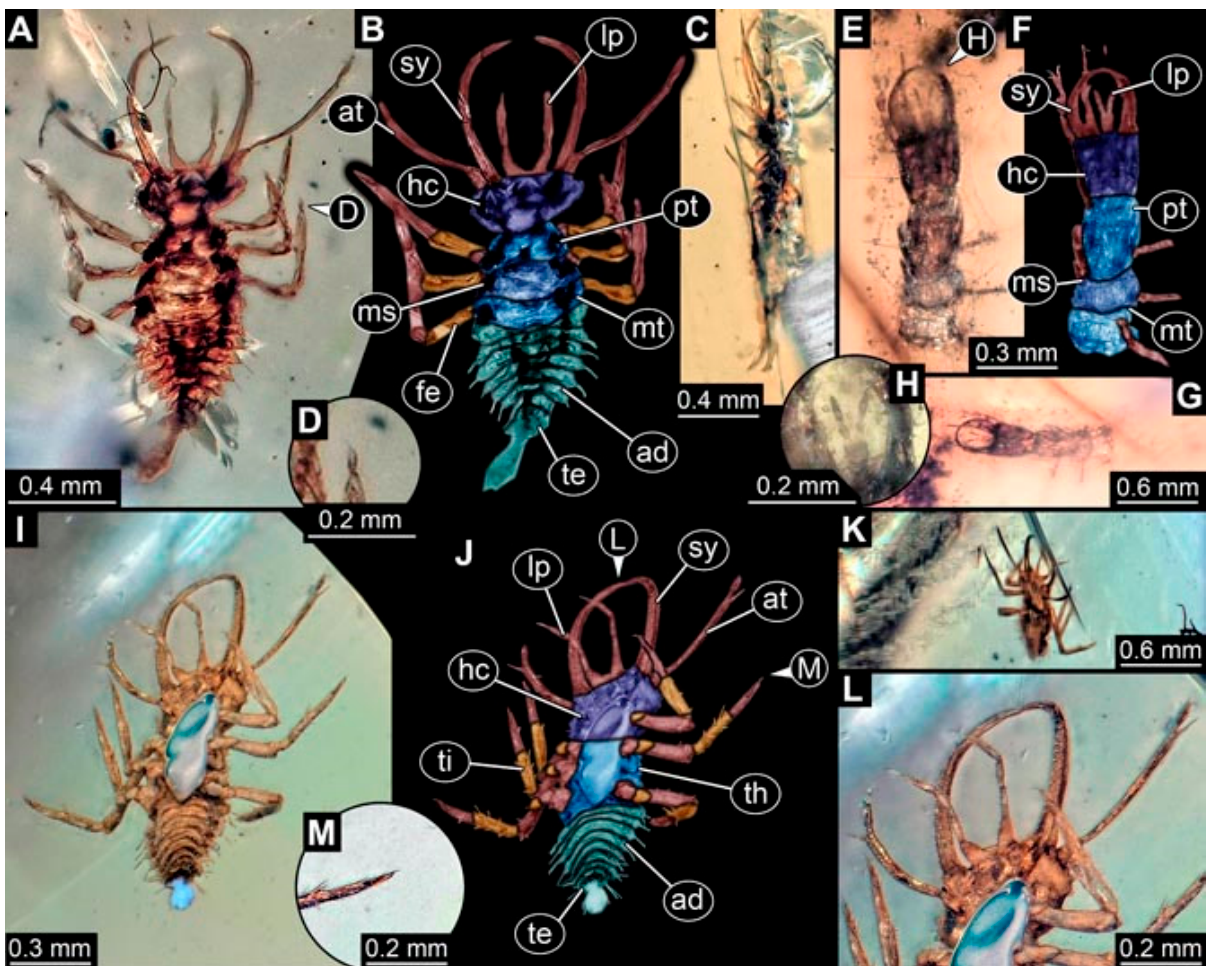
Figure 9. Three specimens in Myanmar amber. ( A – D ) Specimen 4827 (F 3196 BU CJW). ( A ) Dorsal view. ( B ) Dorsal view, colour-marked. ( C ) Lateral view. ( D ) Close-up of distal end of trunk appendage. ( E – H ) Specimen 4829 (PED 0038). ( E ) Dorsal view. ( F ) Dorsal view, colour-marked. ( G ) Ventral view. ( H ) Close-up of labium in dorsal view. ( I – M ) Specimen 4864 (PED 1223). ( I ) Ventral view. ( J ) Ventral view, colour-marked. ( K ) Dorsal view. ( L ) Close-up of head capsule in ventral view. ( M ) Close-up of distal end of trunk appendage. Abbreviations: ad = abdomen; at = antenna; fe = femur; hc = head capsule; lp = labial palp; ms = mesothorax; mt = metathorax; pt = prothorax; sy = stylet; te = trunk end; th = thorax; ti = tibia.